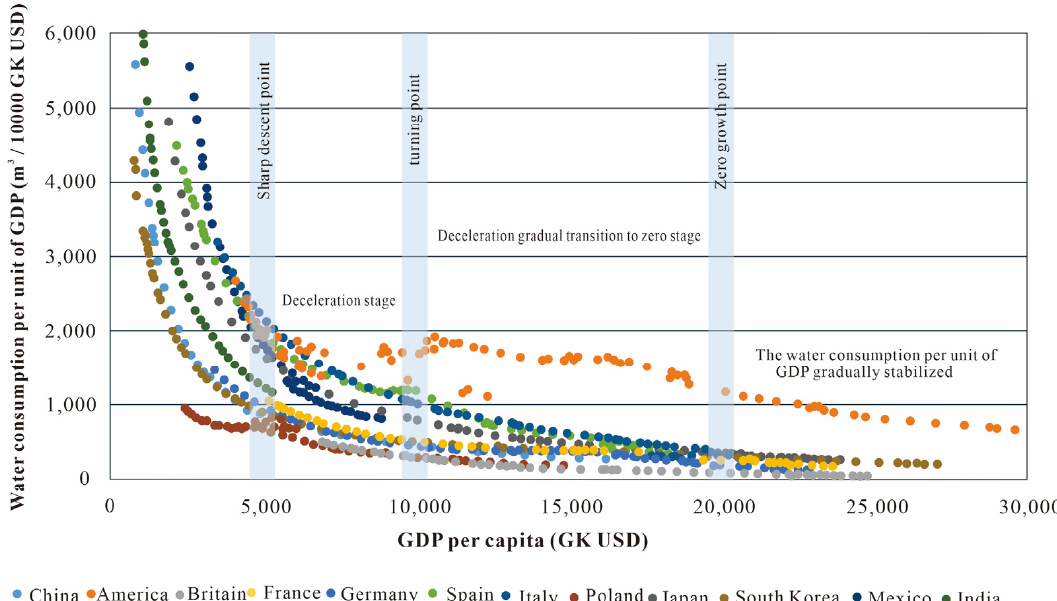
Figure 3. Relationship between water consumption intensity and per capita GDP.